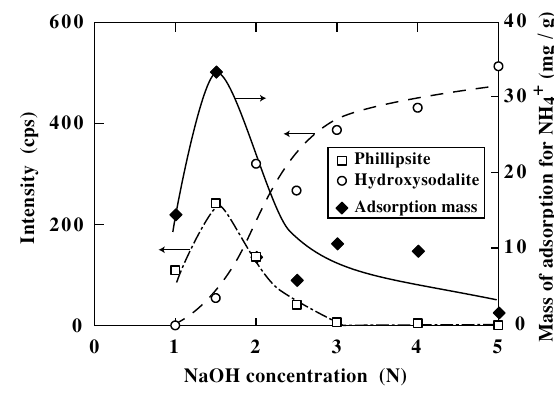
Fig. 2 XRD peak charts for products treated with various NaOHaq.con- centrations (Treatment time = 12hr).